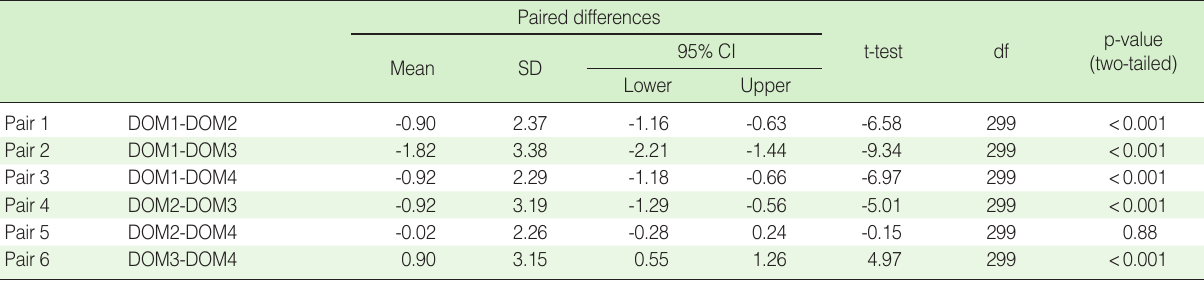
Table 4. Paired t-test for the four domains of the World Health Organization Quality of Life Instrument, Short Form